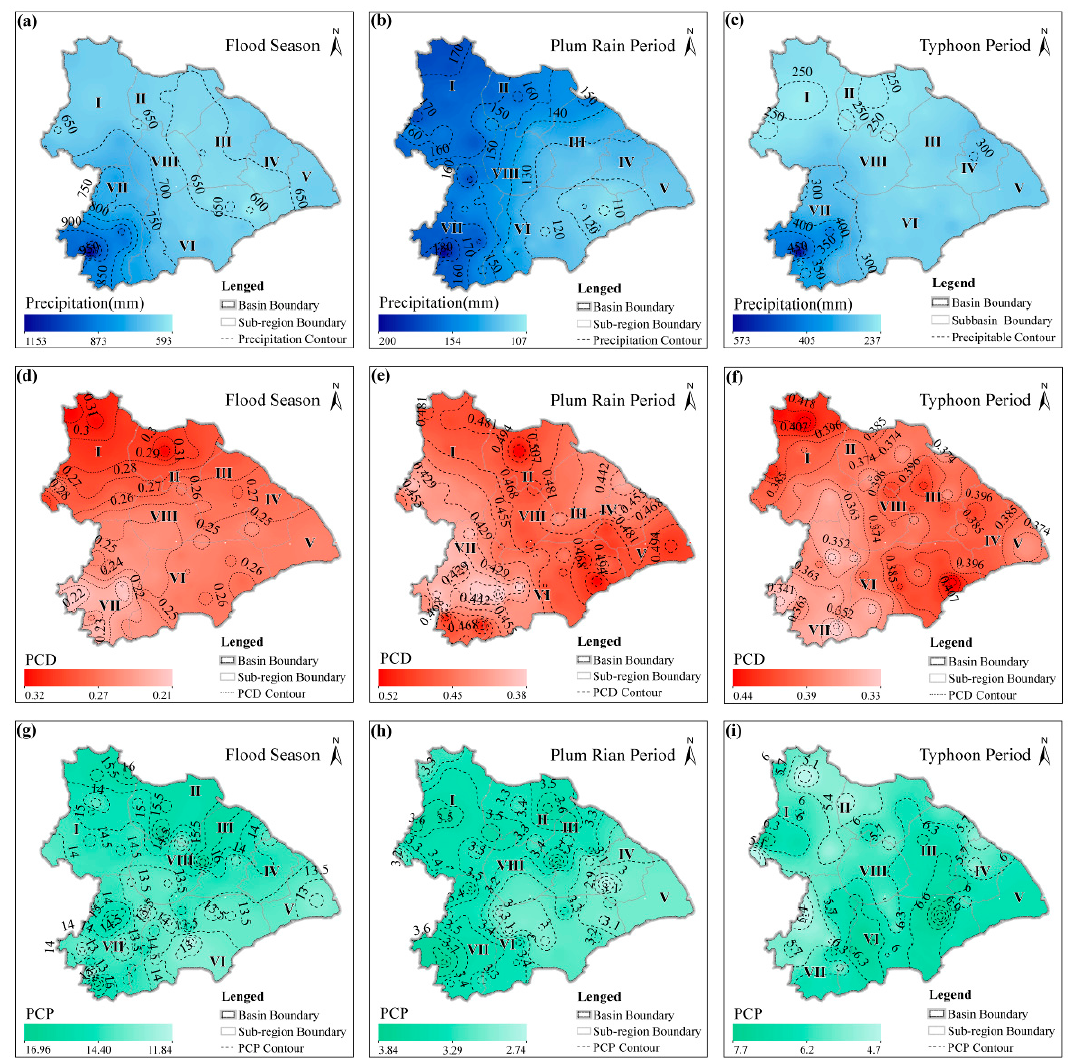
Figure 10. Isogram of precipitation amount ( a – c ), precipitation concentration degree (PCD) ( d – f ), and precipitation concentration period (PCP) ( g – i ) in the Taihu